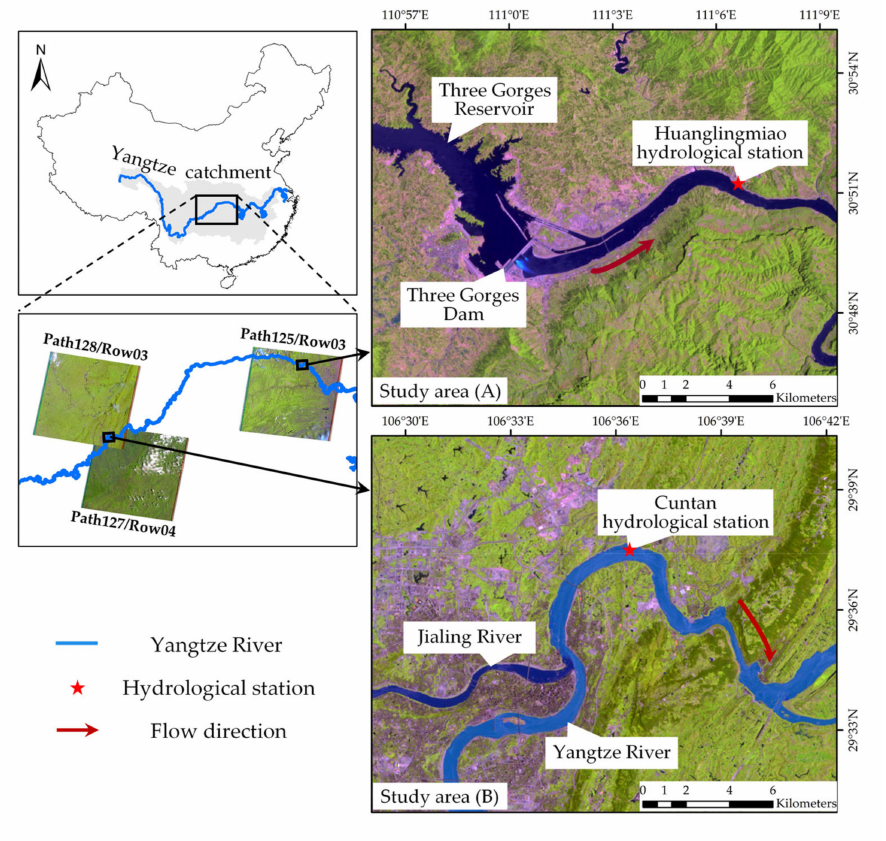
Figure 1. Map of the two selected study areas and hydrological stations: ( A ) Huanglingmiao ( B ) Cuntan in the Yangtze